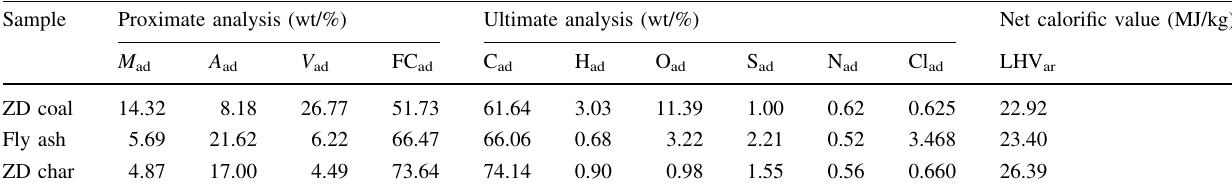
Table 1 Proximate and ultimate analyses of samples Sample